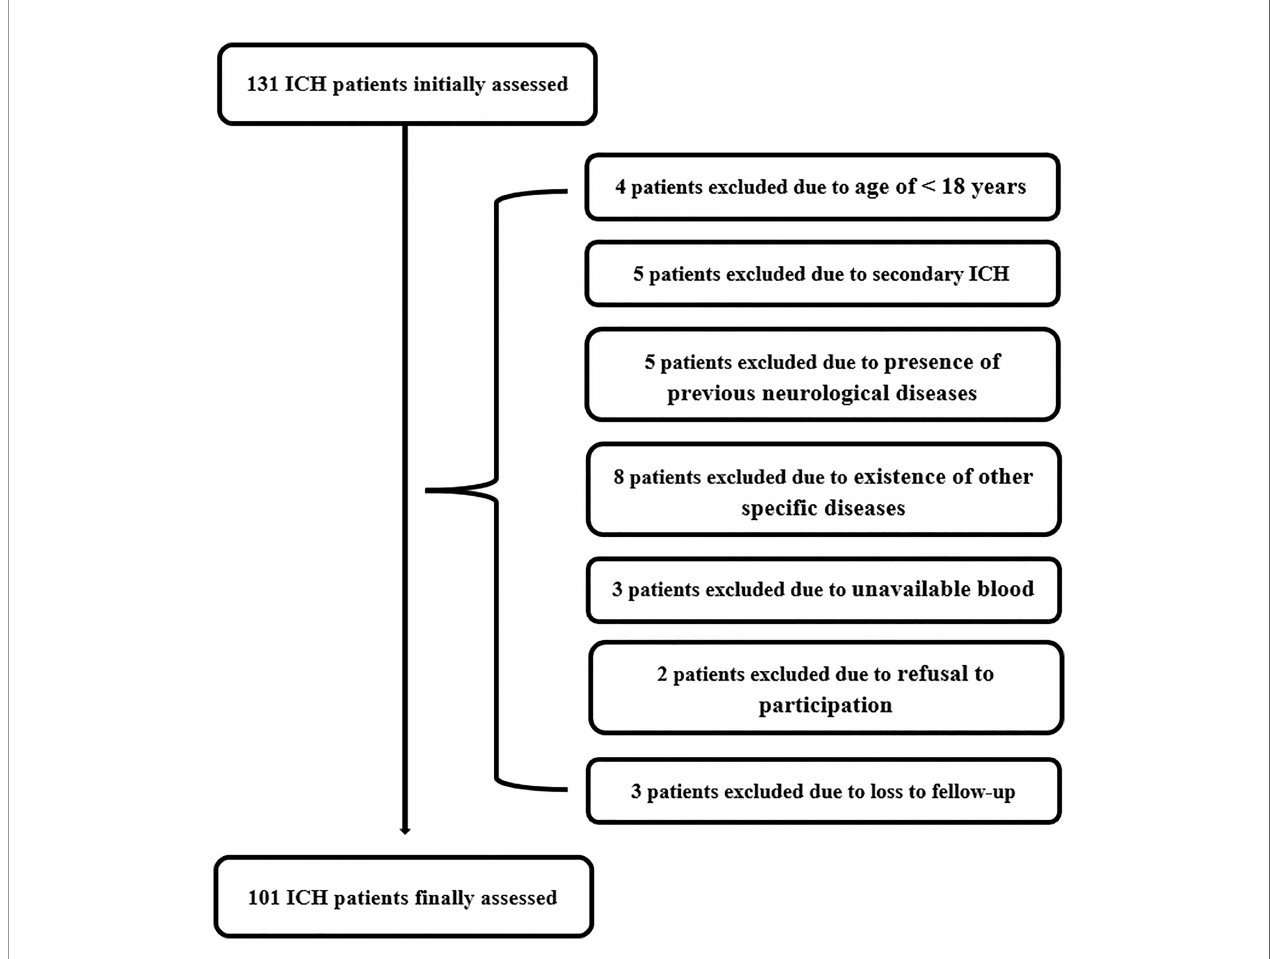
FIGURE 1 | Flow chart of selecting eligible patients with acute spontaneous intracerebral hemorrhage. Initially, 131 intracerebral hemorrhage patients were assessed; thereafter, we excluded 30 patients; and ultimately, 101 patients were recruited. ICH indicates intracerebral